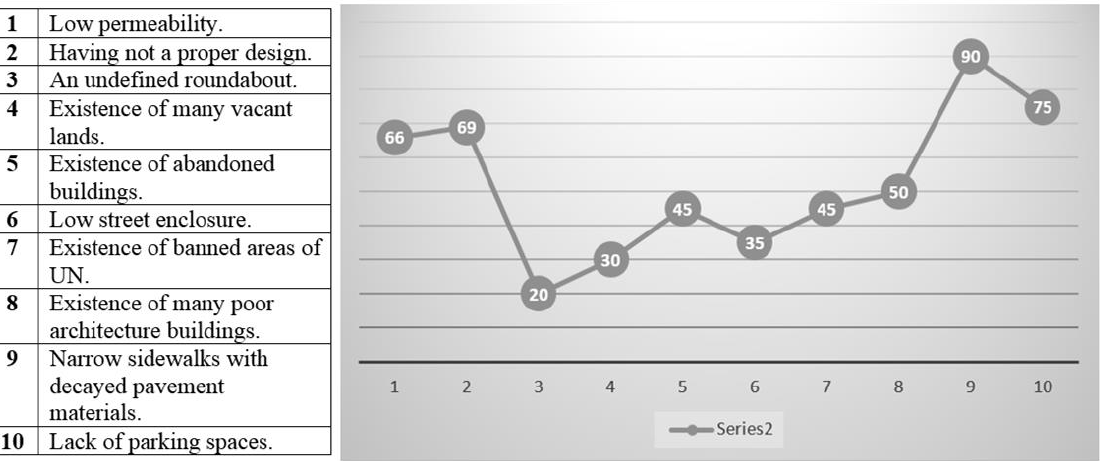
Table 2. Problems regarding to Walkability in Salamis